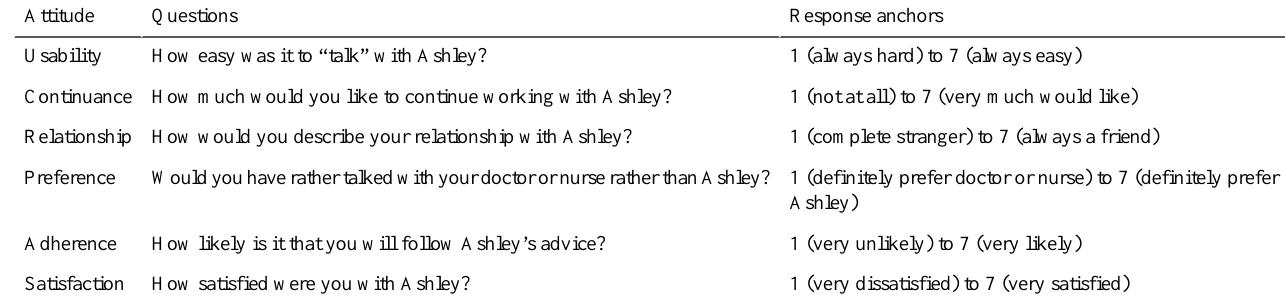
Table 3. Attitude scale (adapted from Bickmore et al